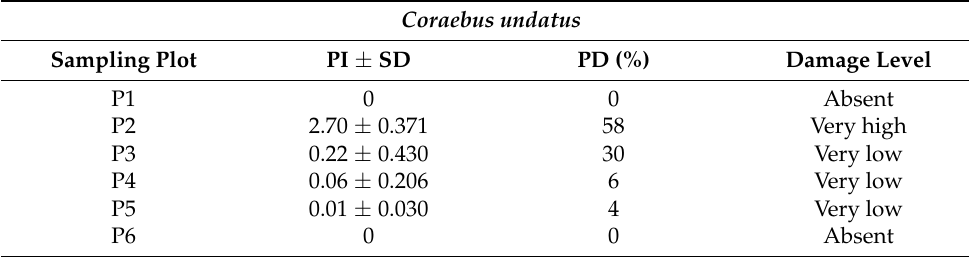
Table 4. Incidence of C. undatus estimated from Plot Infestation rate (PI), the percentage of damaged cork oaks (PD) in relation to the total sampled trees and to the damage level obtained in each sampling plot (P). SD = standard